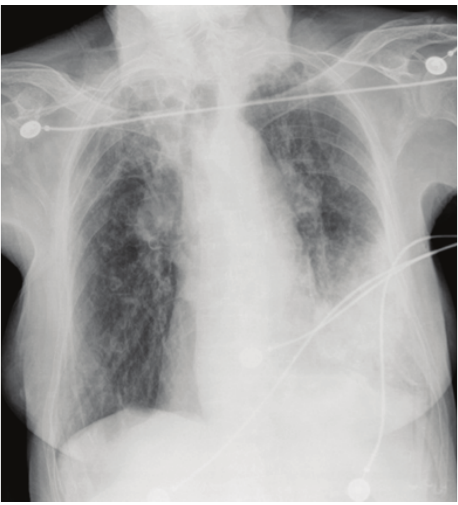
Figure 1: Chest X-ray on admission: left lower lobe alveolar infil- trate.